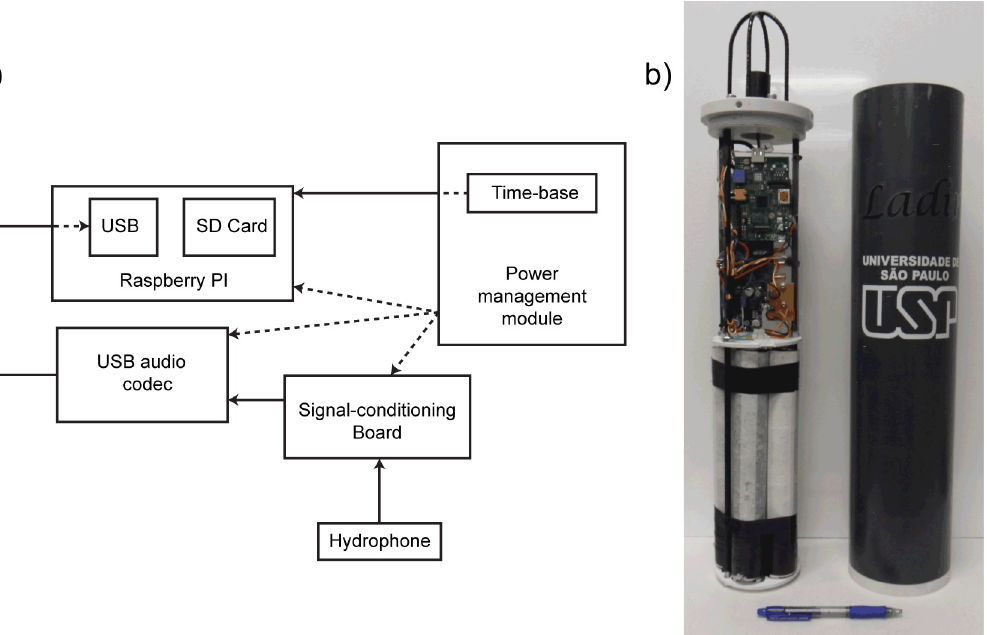
Fig 1. (a) The schematic representation shows the components of the autonomous underwater recording device and (b) the waterproof PVC enclosure, which contained the